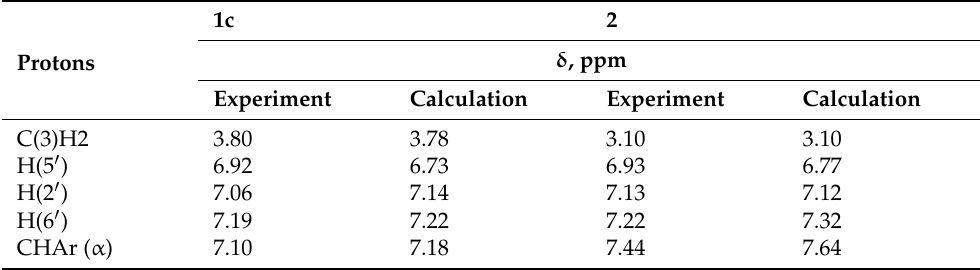
Table 1. Proton chemical shifts of compounds 1c and 2 averaged taking account of the mole fractions of conformers in comparison with experimental data (in CD 2 Cl 2 ).